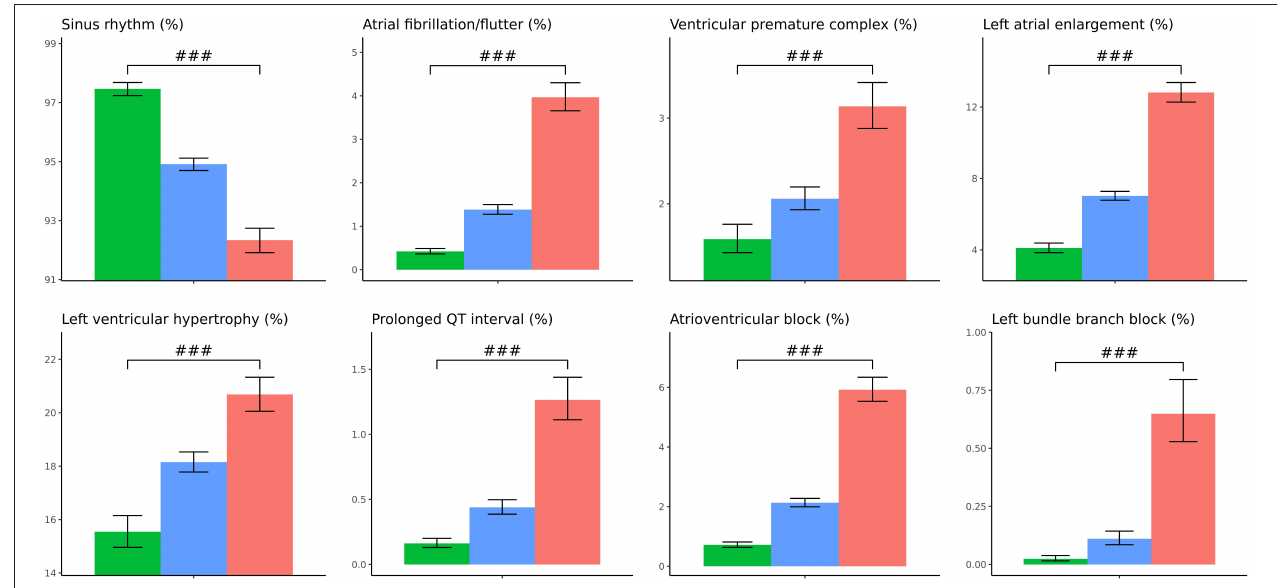
FIGURE 5 | The relationship between ECG-age and ECG important features. The plots display three groups, with ECG-age more than 7 years greater than the chronological age (denoted by: ECG-age –Age > 7, red columnar) those with ECG-age within a range of 7 years from their chronological age (denoted by: ECG-age –Age-7 to 7, blue columnar); and, those with ECG-age more than 7 years smaller than the chronological age (denoted by: ECG-age –Age < 7, green columnar). Sinus rhythm is associated with ECG-age –Age < 7, green columnar. ECG abnormal is associated with ECG-age –Age > 7, red columnar. # p < 0.05; ## p < 0.01; ### p <